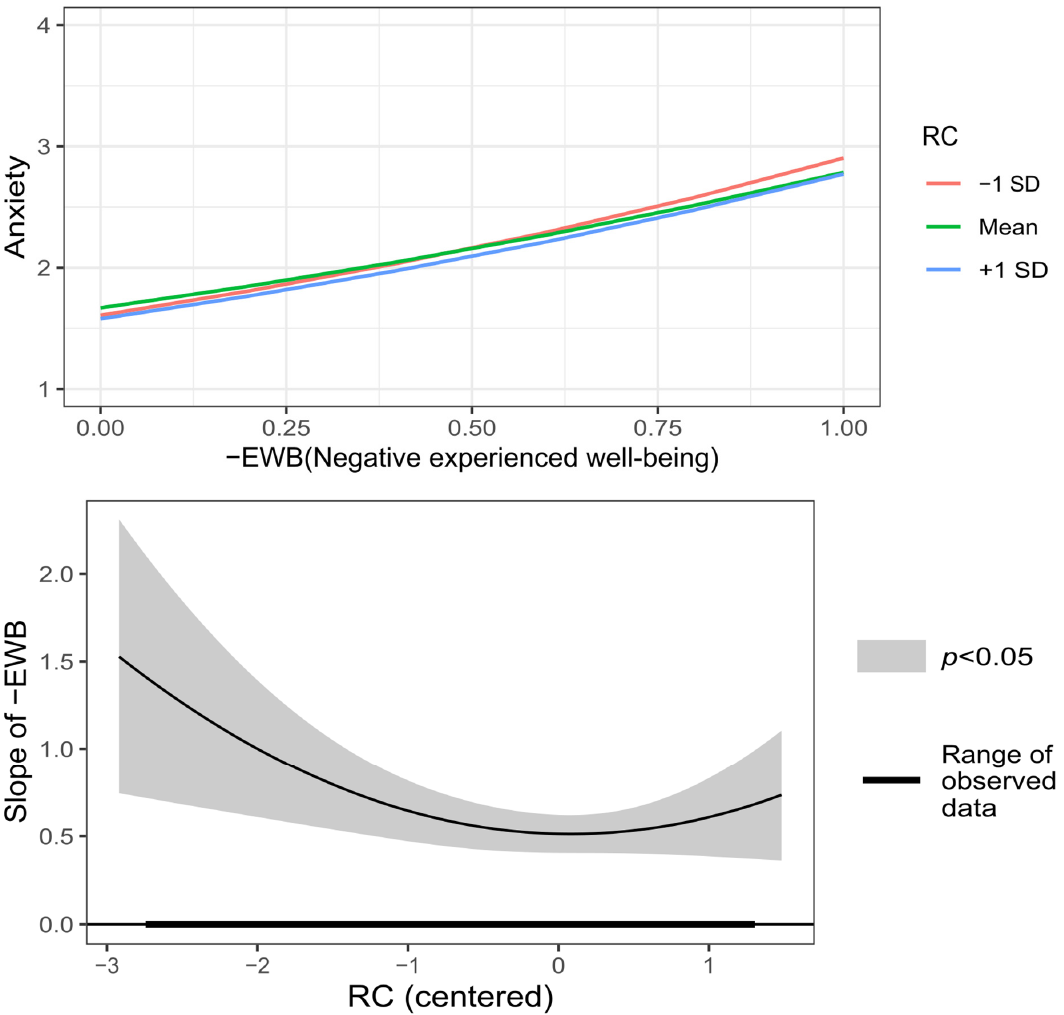
Figure 5. Graphic representation of RC (Resilient coping) moderation on the relationship between − EWB (Negative experienced well-being) and anxiety symptoms.